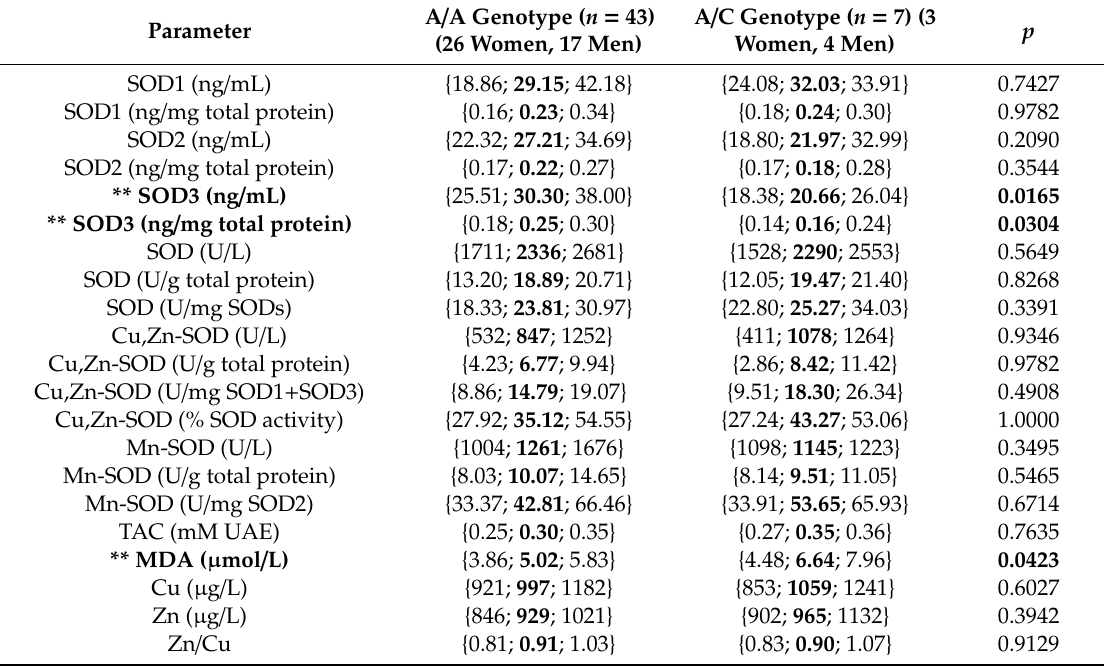
Table 9. Values of selected pro- and antioxidative parameters, and concentration of selected metals, in context of genotypic variability of rs2234694 ( SOD1 ), in non-obese